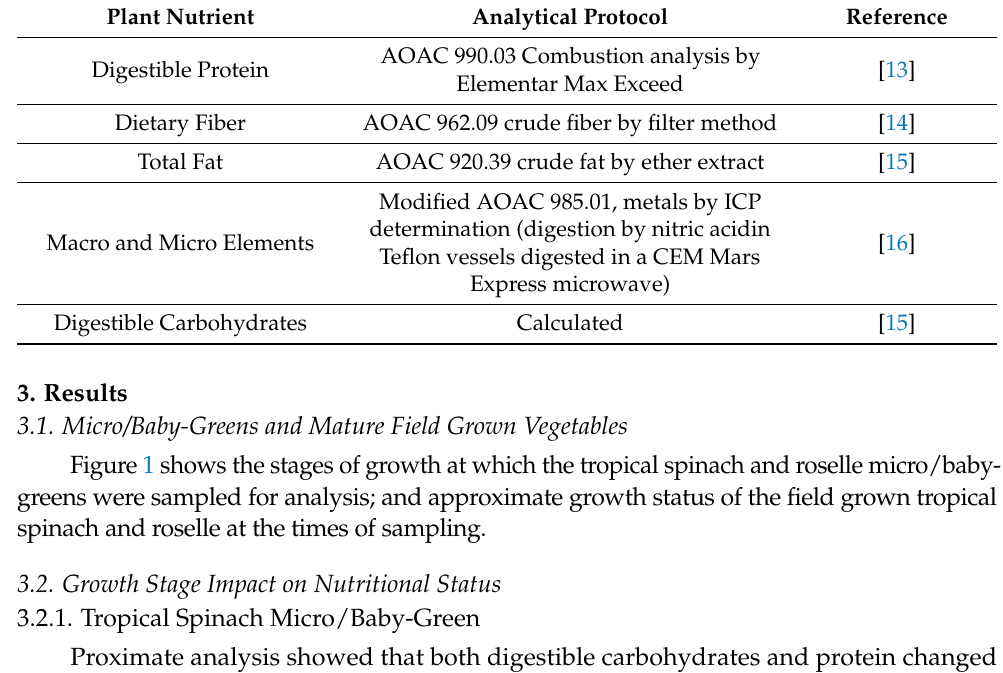
Table 1. Plant analytical methods for digestible carbohydrates, digestible protein, dietary fiber, total fat, and elemental macro-and micro-nutrients (based on dry matter samples). Plant